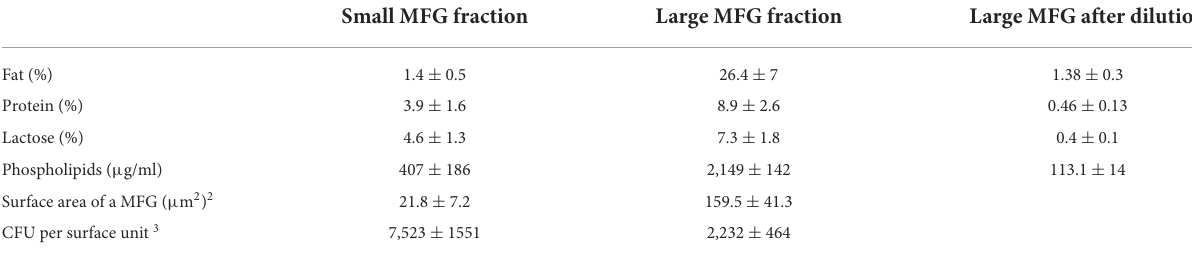
TABLE 1 Percentage of milk solids and content of phospholipids in the small and large MFG fractions before normalization and after normalization to fat content (dilution of the large MFG